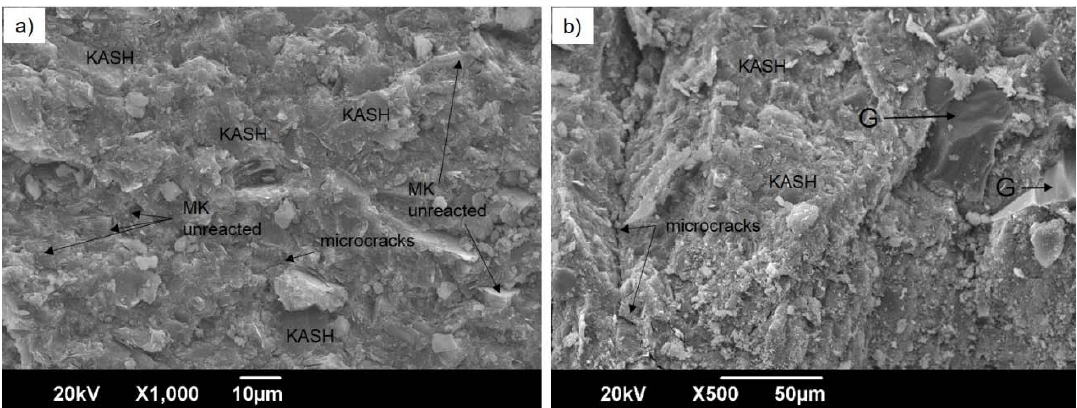
Figure 7. SEM images of the samples with 10 wt.% TiO 2 : ( a ) GP and ( b ) GP ‐ G mortar. Figure 6. Fourier ‐ transform infrared (FTIR) spectra obtained for MK, GP, and GP ‐ G.